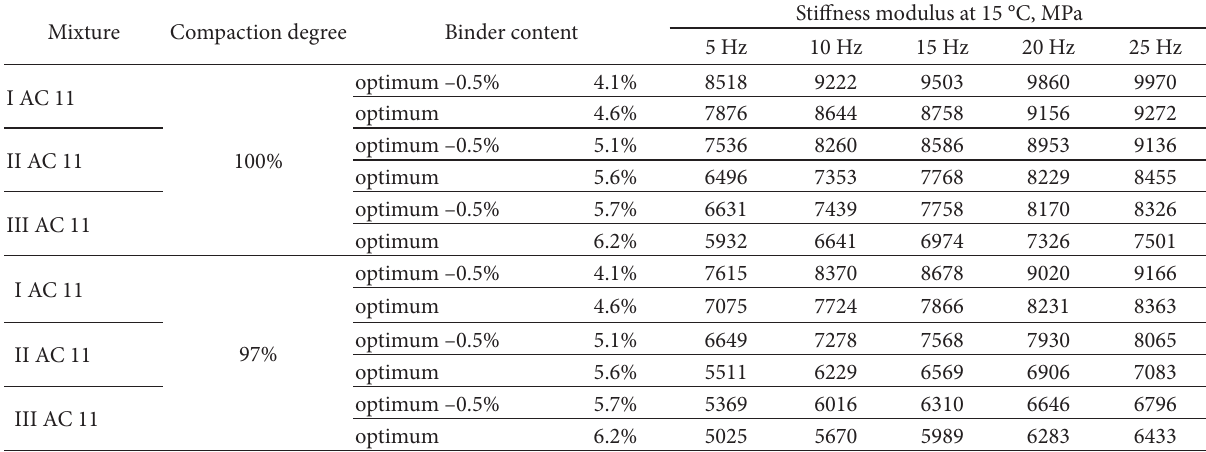
Table 3. Stiffness modulus of AC 11 mixtures